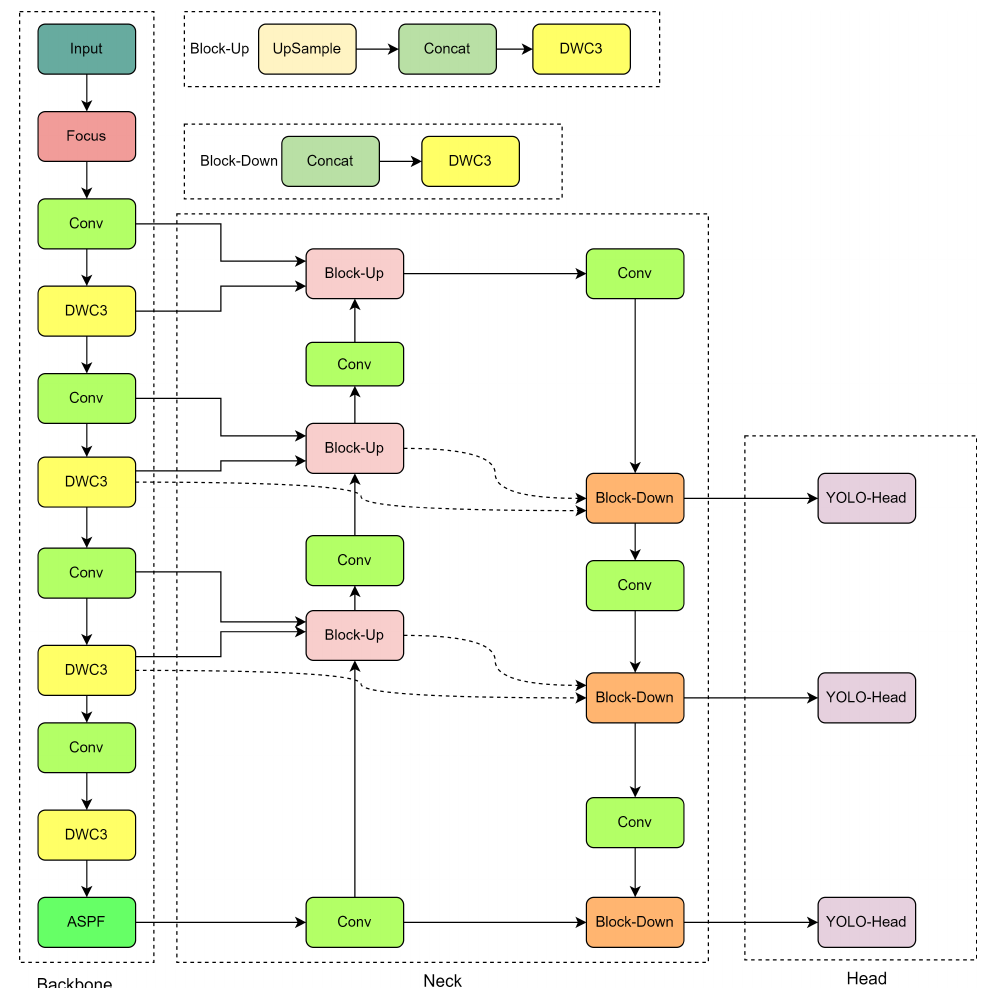
Figure 1. The overall architecture of the model, DWC3 forms the backbone network with a modified ASPF at the end; the neck uses dense multi-scale fusion to introduce a shallow feature map; the target is detected by three detection heads of different